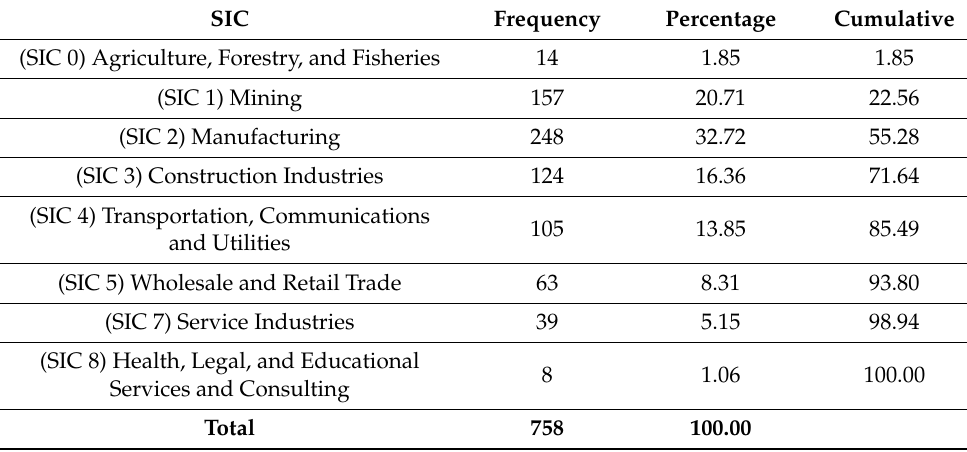
Table 4. Sample distribution by